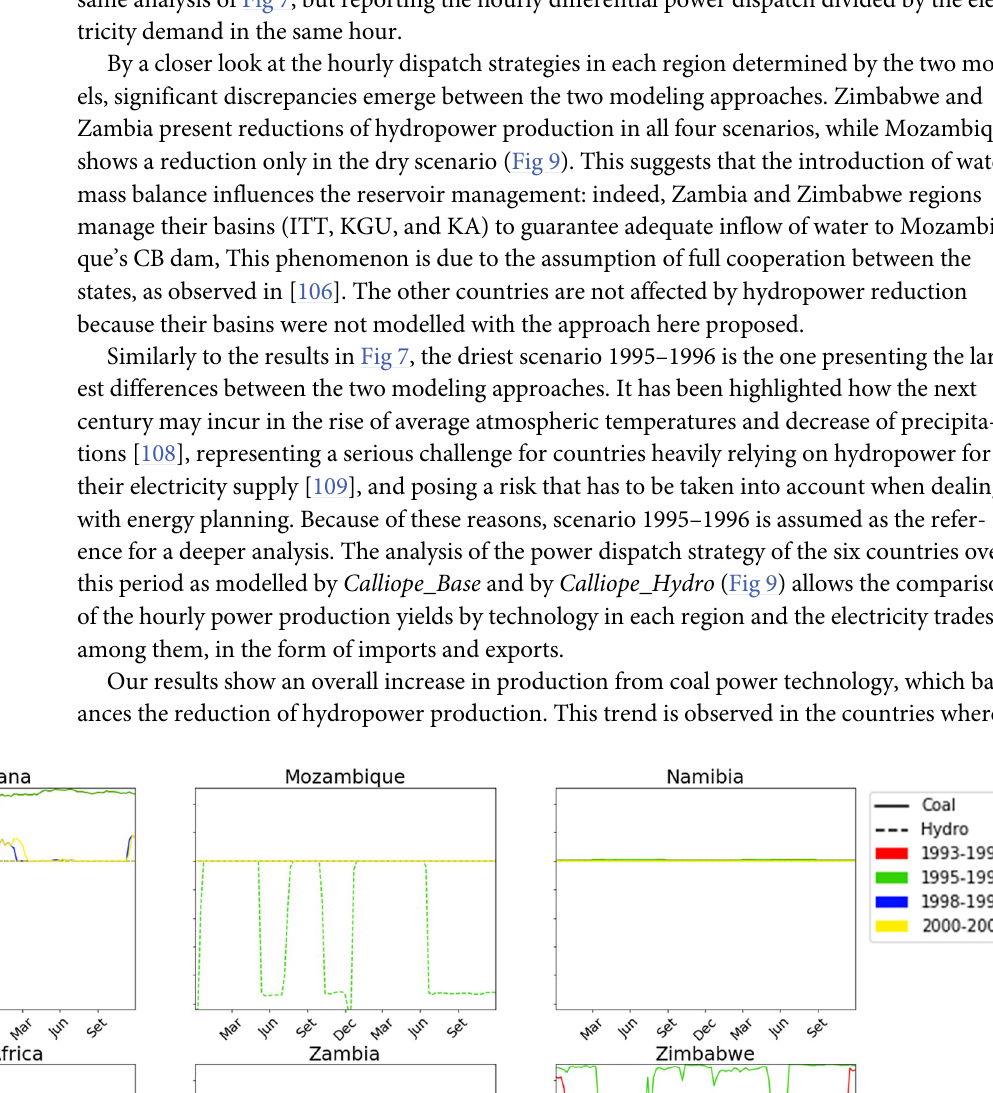
PLOS ONE | https://doi.org/10.1371/journal.pone.0259876 December2,